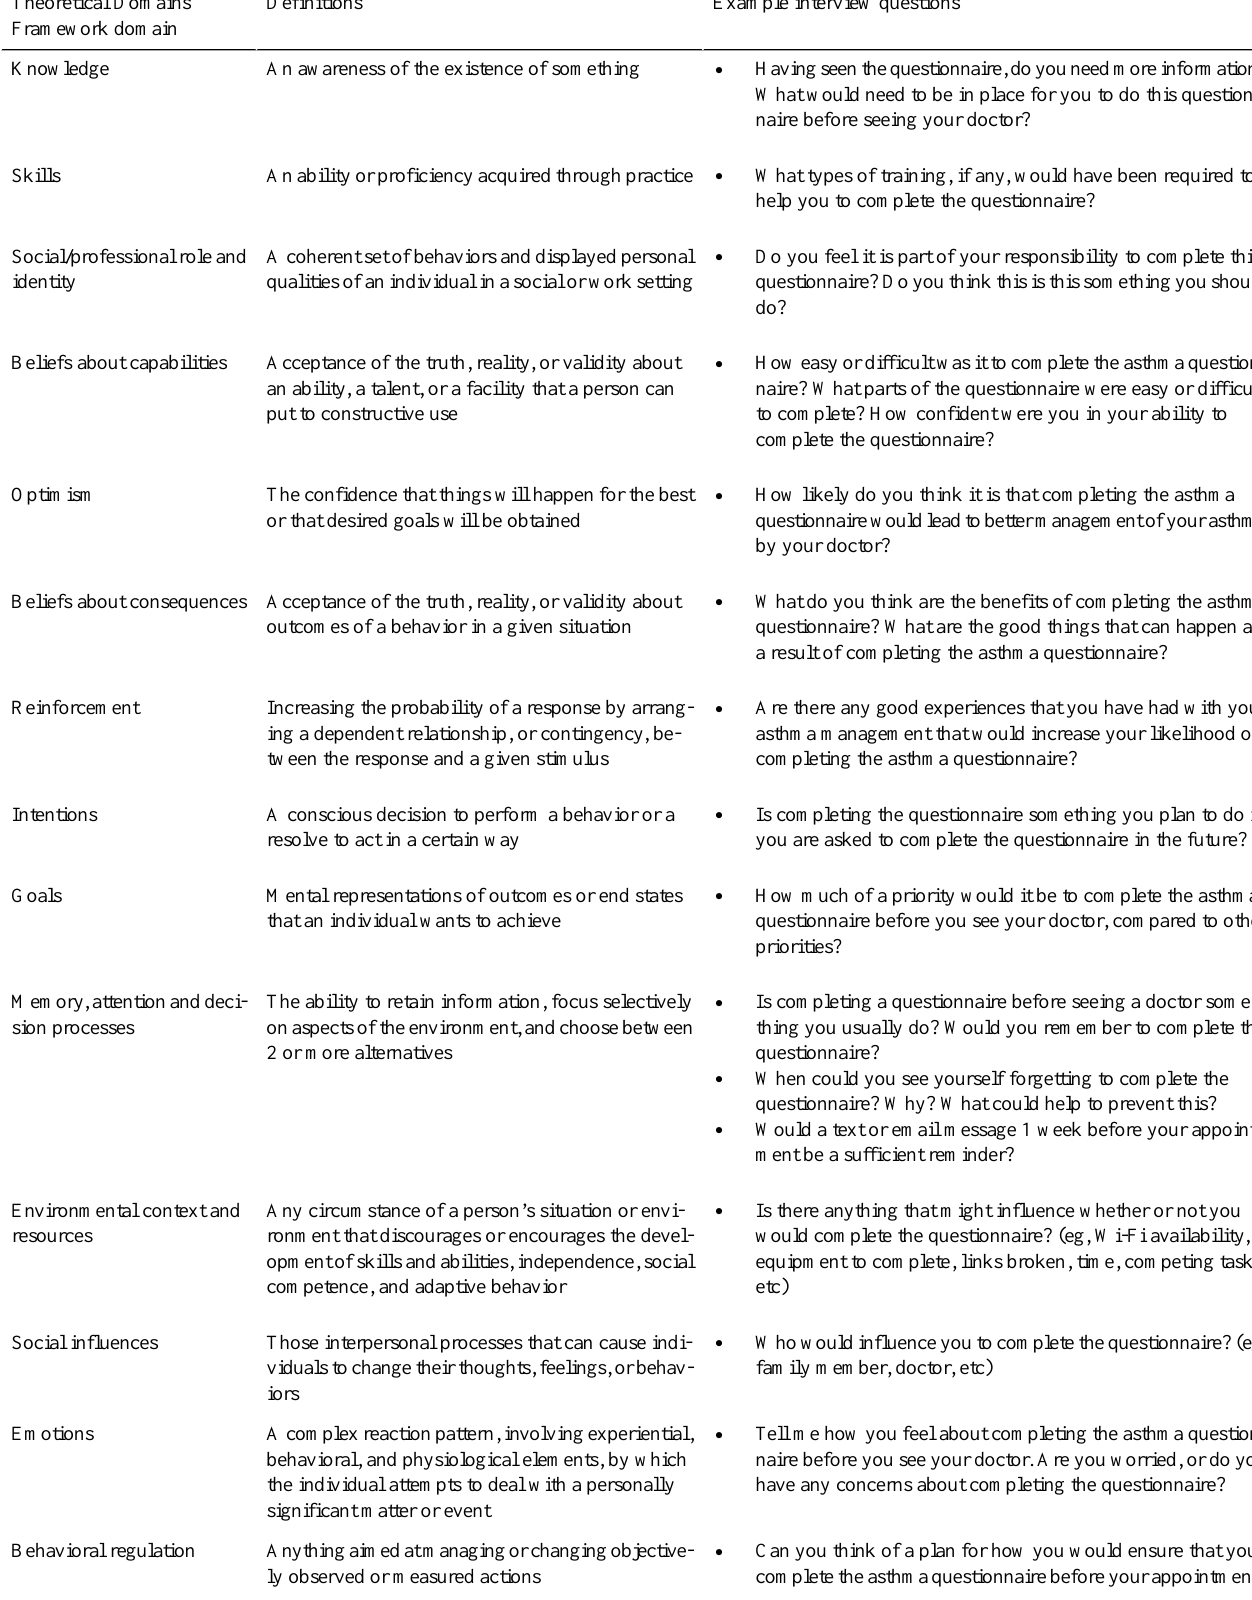
Example interview questionsDefinitionsTheoretical Domains